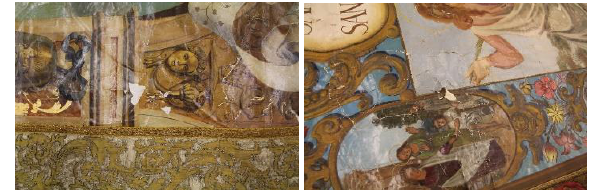
Figure 7 – Examples of superficial laceration on banners S. Eloy (left) and Sta Justa (right)